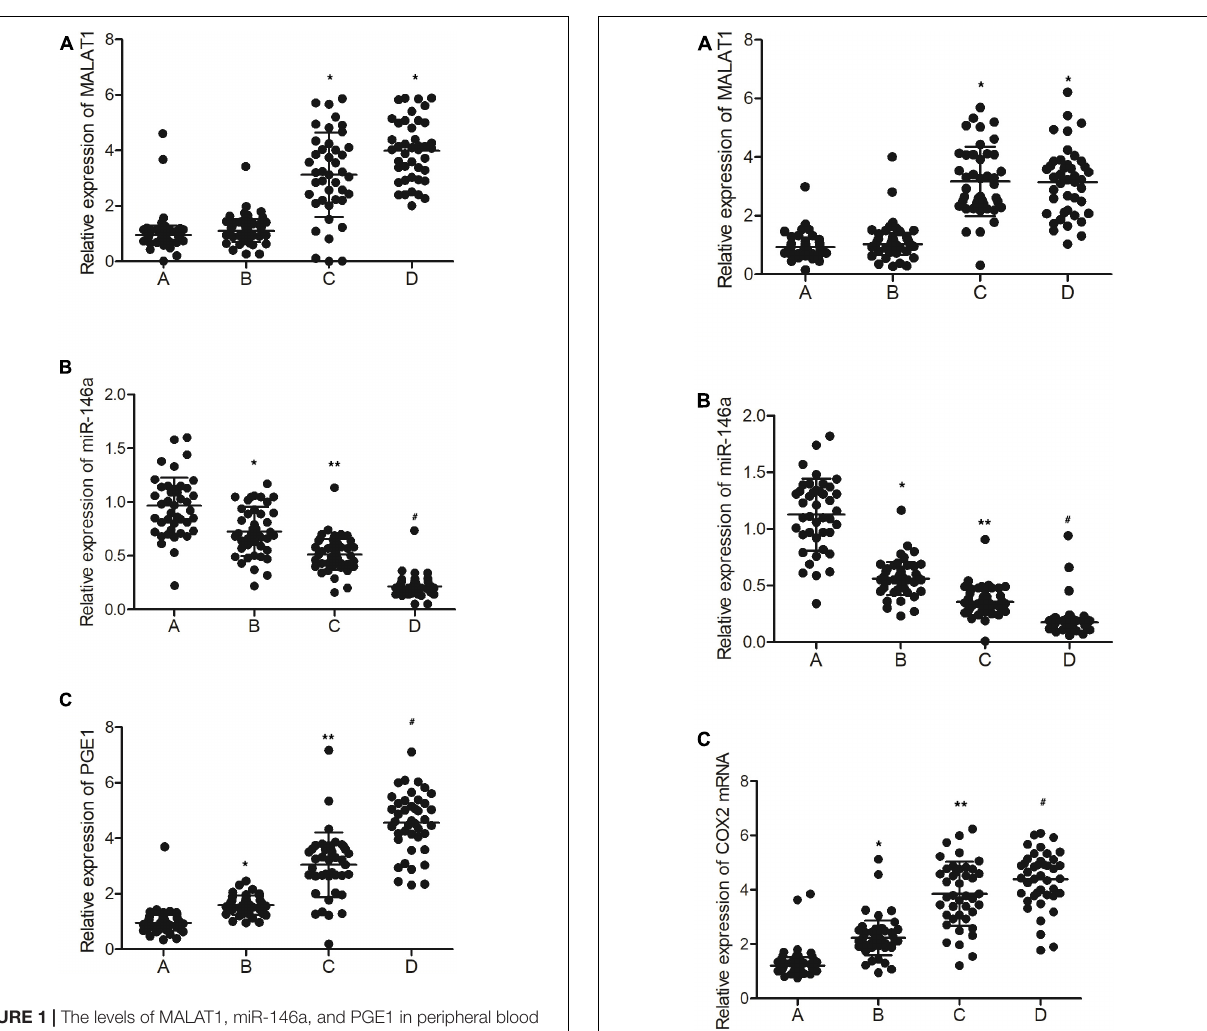
FIGURE 1 | The levels of MALAT1, miR-146a, and PGE1 in peripheral blood samples were different among different groups (A: MALAT1 HYPER + miR-146a HYPO group; B: MALAT1 HYPER + miR-146a HYPER group; C: MALAT1 HYPO + miR-146a HYPO group; D: MALAT1 HYPO + miR-146a HYPER group. * p < 0.05 vs. group A; ** p < 0.05 vs. group B; # p < 0.05 vs. group C). (A) Relative expression of MALAT1 in the peripheral blood samples was similar between the MALAT1 HYPER + miR-146a HYPO group and the MALAT1 HYPER + miR-146a HYPER group, while being lower than that of the MALAT1 HYPO + miR-146a HYPO group and the MALAT1 HYPO + miR-146a HYPER group. (B) Relative expression of miR-146a in the peripheral blood